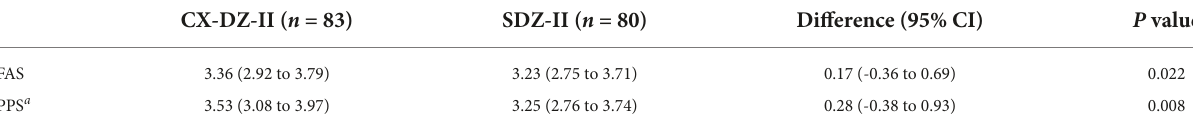
TABLE 2 Primary